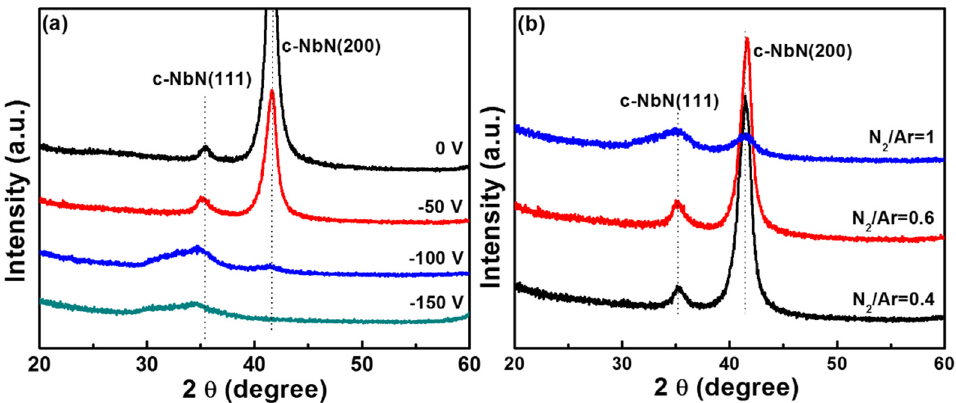
Figure 2. XRD patterns of NbN x >1 coatings deposited under different bias voltages with constant 0.6 ratio of N 2 /Ar ( a ); and under different N 2 /Ar gas ratios with constant − 50 V bias voltage ( b